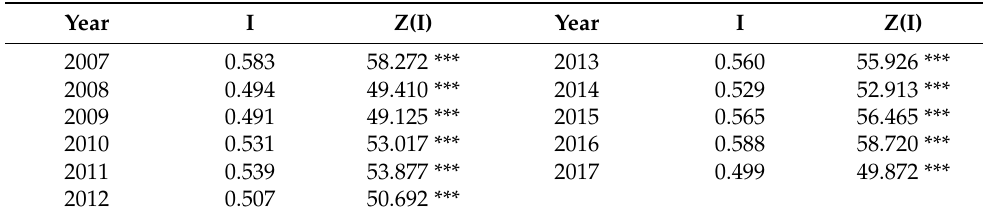
Table 2. Results of global spatial autocorrelation. Year I